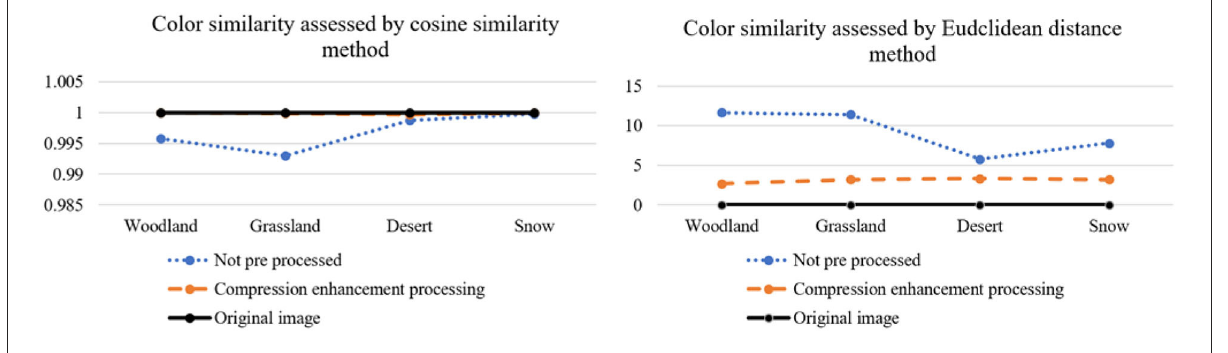
FIGURE14 Color similarity assessment results.